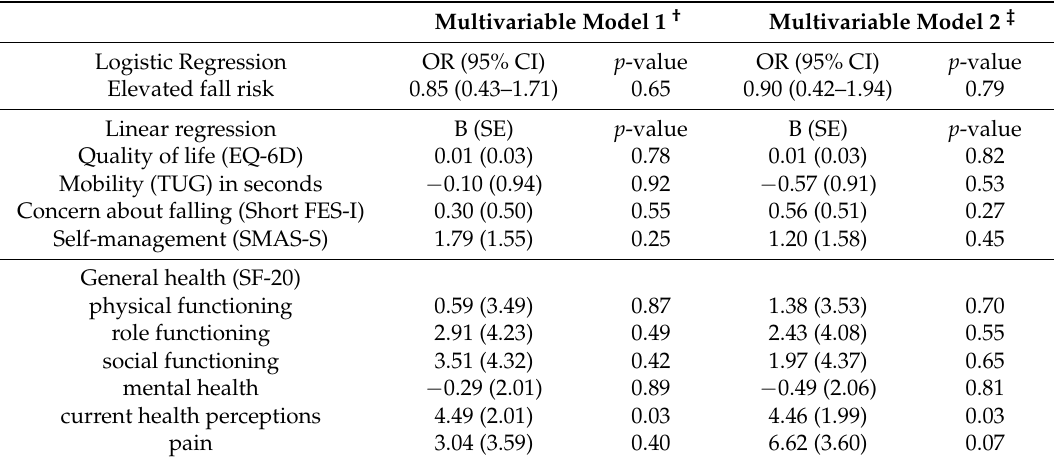
Table 3. Effects of frequent participation in the home-based exercise program on health-related